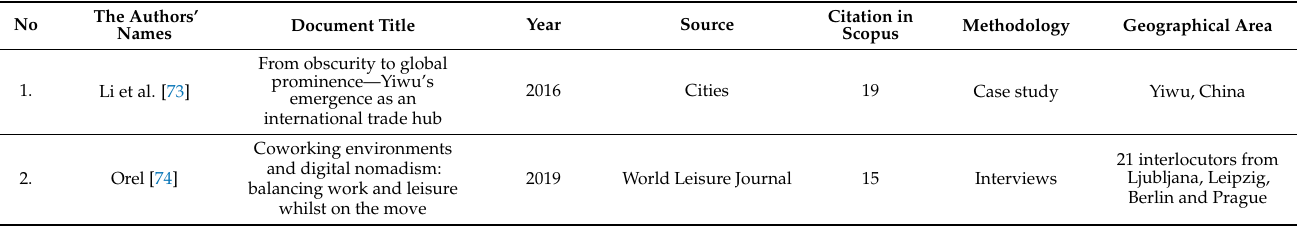
Table A1. Documents related to city logistics in the urban tourist field, in the subject area of business, management, and accounting, in 2011–2022. Source: Own elaboration based on data collected from Scopus database on 23 February